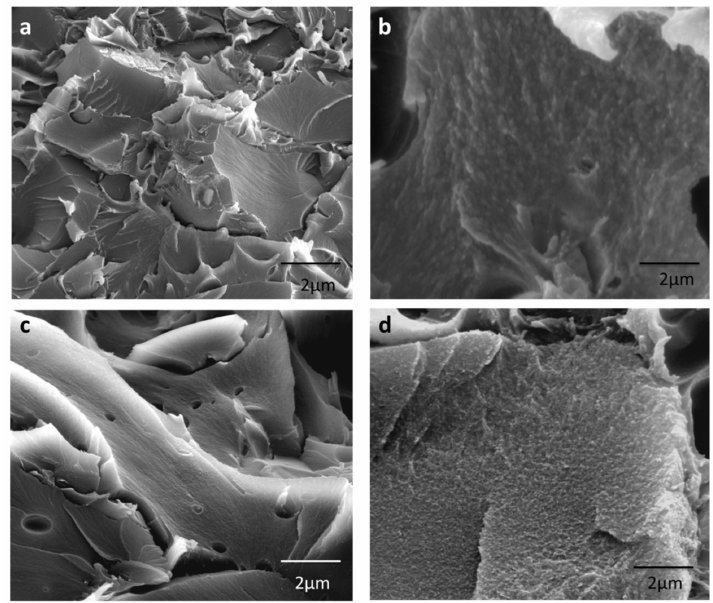
Figure 7. SEM micrographs of MMMs and their corresponding TR-PBO: ( a ) HPA30, ( b ) TRHPA30, ( c ) PAA30 and ( d ) TRPAA30. In any case, real pores cannot be confused with non-interconnecting grooves or cavities probably caused by solvent